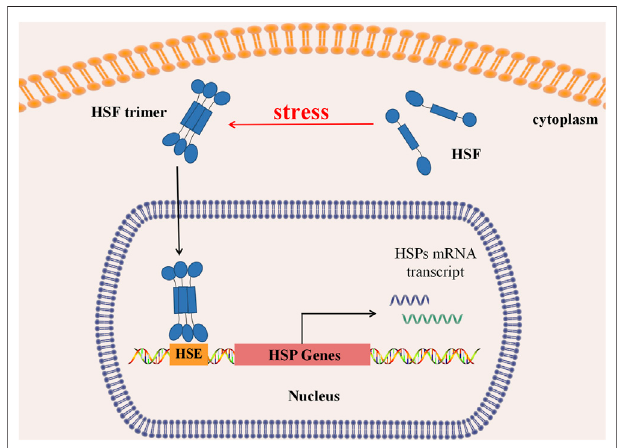
FIGURE 2 | Regulation of heat shock response. In normal, HSFs stay in the cytoplasm as a monomer. Under stress, HSFs aggregate to form a trimer, which can be actively transported into the nucleus and binds with the Heat Shock regulatory element (HSE) to initiate downstream HSP transcription, causing Heat Shock Response (HSR), regulating transcription and expression of Heat Shock